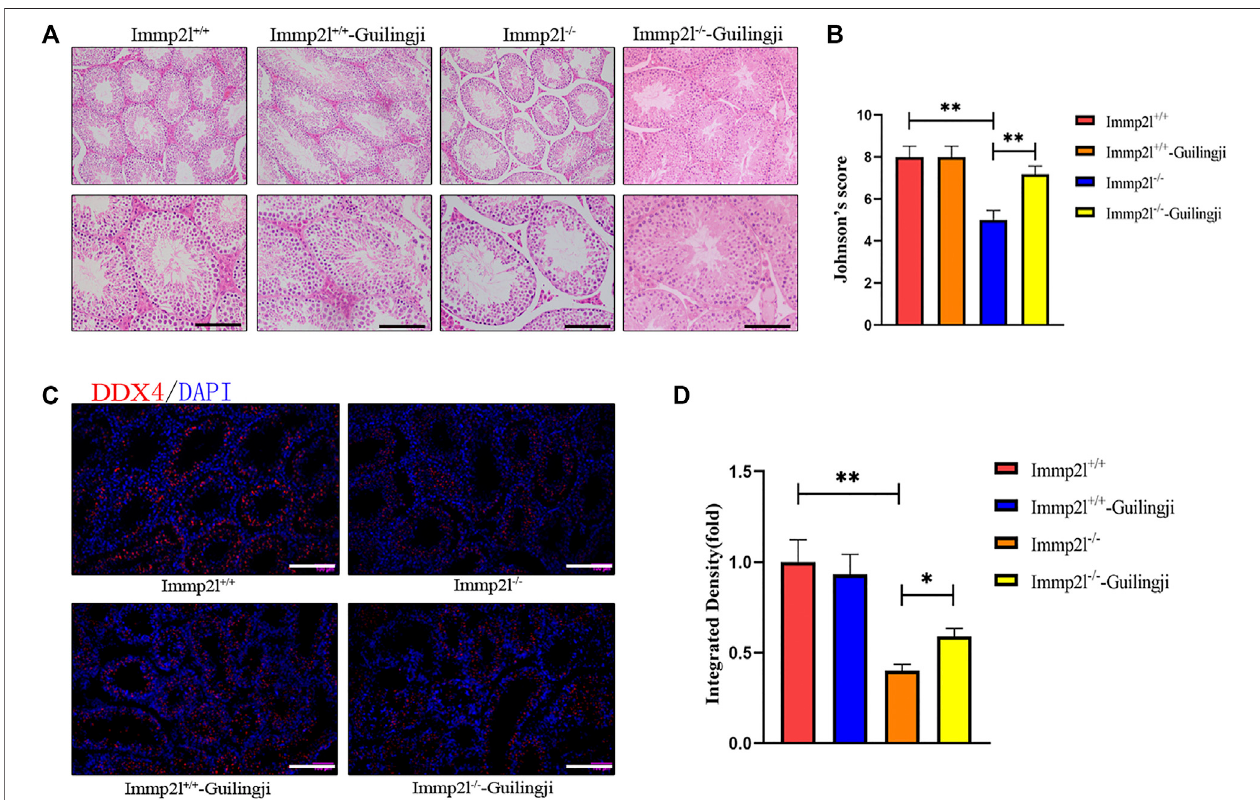
FIGURE 2 | Guilingji treatment repairs testicular damage as assessed by histopathology. (A) Transverse sections of testis tissues were stained with hematoxylin andeosin(HE).Scalebar (cid:1) 20 μ m;and (B) SpermatogenesiswasevaluatedbyJohnson ’ sscore.** p < 0.01. n (cid:1) 6. (C) ImmunostainingrevealedtheexpressionofDDX4 in testis after Guilingji treatment. The nuclei were counterstained with DAPI (blue). Scale bar (cid:1) 100 μ